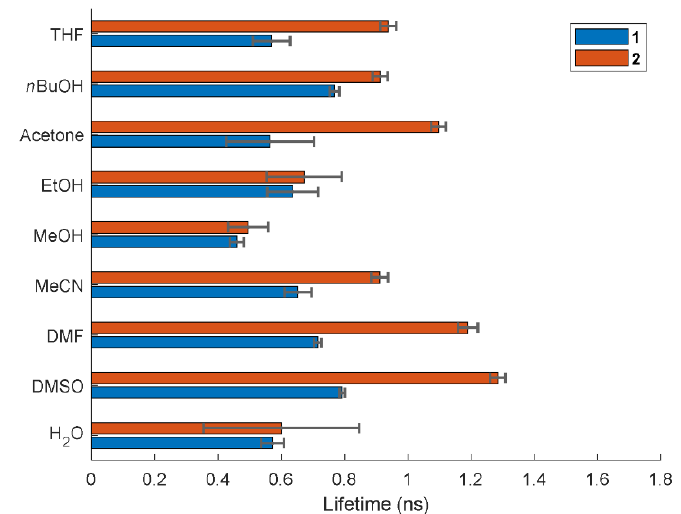
Figure 4. Fluorescence lifetimes for compounds 1 and 2 in different solvents. Spectral data in each time bin were first averaged using a five-point moving mean. A least squares single exponential fit was then performed using five-time bin positions ranging from 0.8 ns to 4 ns. Final lifetime values were obtained through averaging over a 586–603 nm wavelength range.